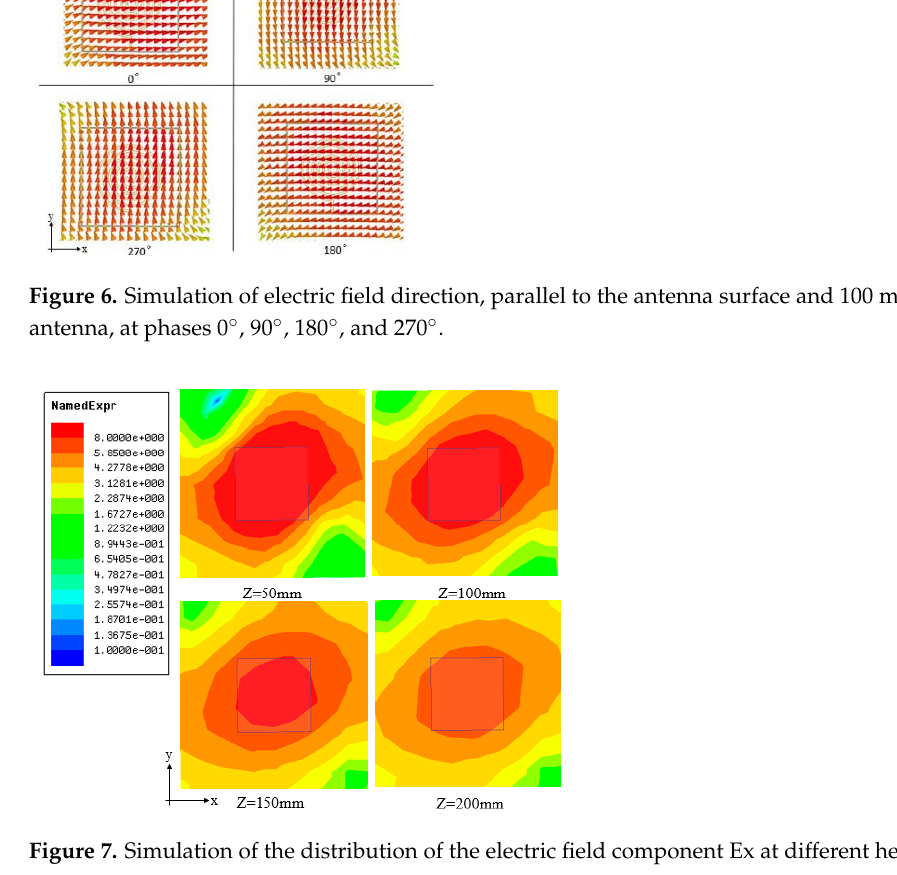
Figure 6. Simulation of electric field direction, parallel to the antenna surface and 100 mm from the antenna, at phases 0°, 90°, 180°, and 270°.